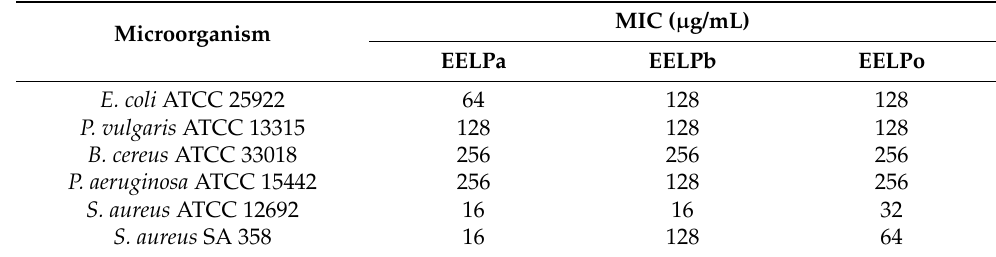
Table 3. Minimum inhibitory concentration (MIC) of ethanol extracts of P. amboinicus , P. barbatus , and P. ornatus fresh